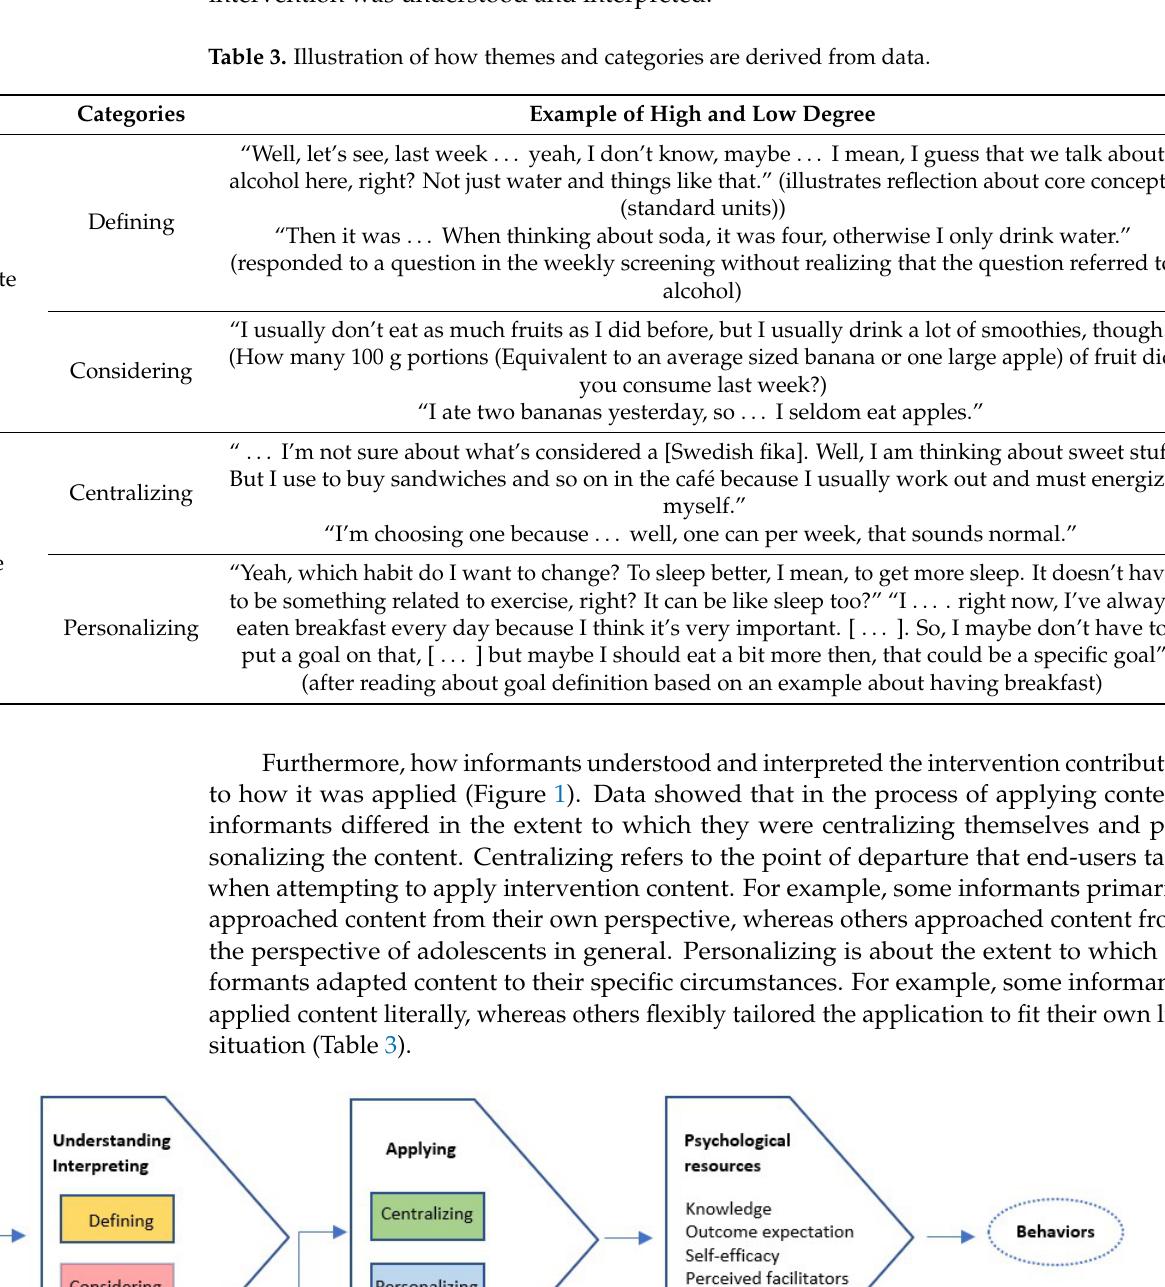
Figure 2. Typologies illustrating different patterns of deliberate and flexible engagement with an mHealth intervention (Life4YOUth).